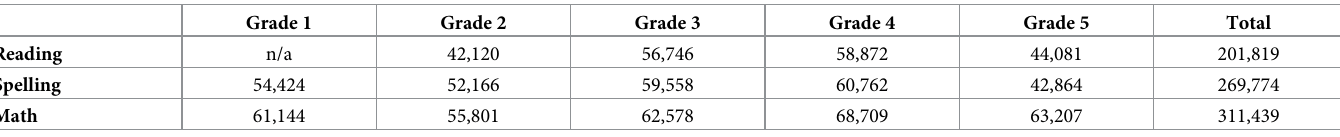
Table 2. Number of test records per domain per